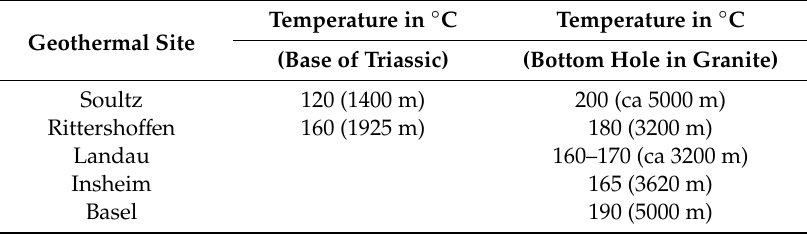
Table 1. Temperatures measured in the drillholes of five geothermal sites in France (Soultz and Rittershoffen), Germany (Landau and Insheim) and Switzerland (Basel), after [12,17]. For location map, see Figure 2.